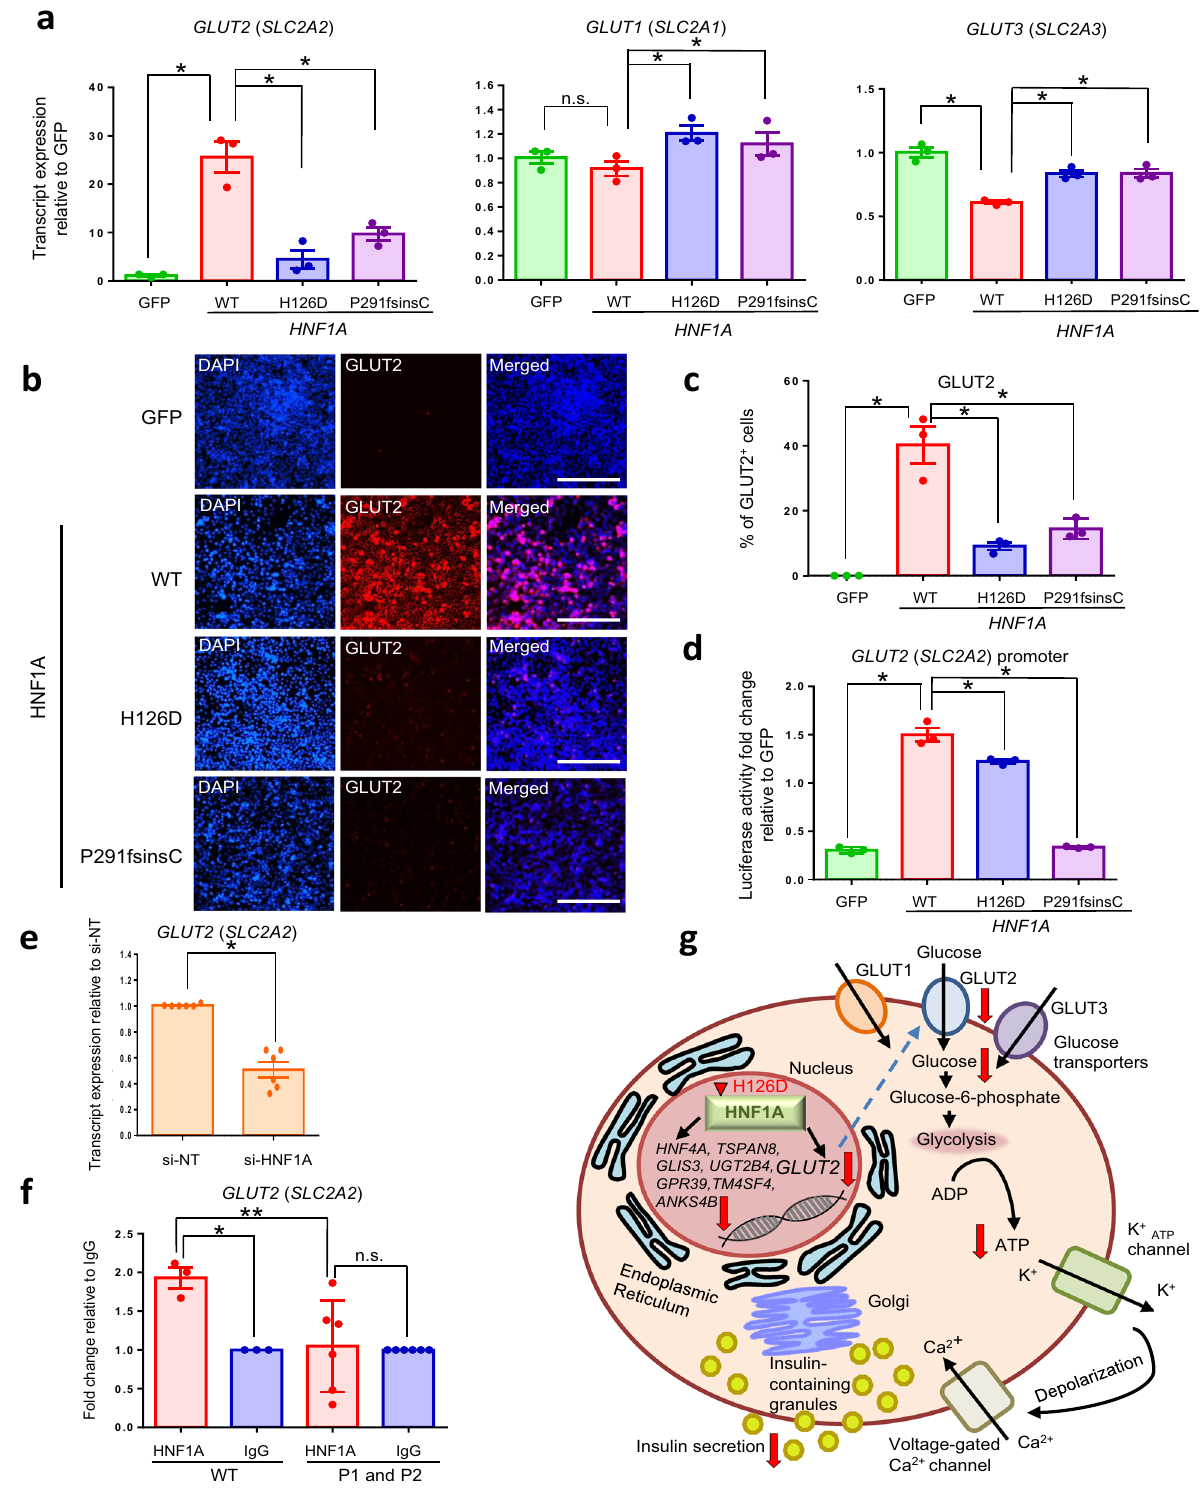
loading concentration with Hybridization buffer (HT1). The NEXTSEQ High Output was performed using the Illumina NEXTSEQ 500 Sequencers with the Illumina ® Reagent v2 (75 cycle kit) Kit. The DNA was attached to the fl owcell surfaces and ampli fi ed to clusters, followed by attachment with the Sequencing primers and run at 1 ×76cycles, generating Single-Read 75 base-pair reads. The images were captured by the NextSeq Control Software (NCS), and the Real Time Analysis (RTA) software converted the images into Basecall (bcl) fi les. All the bcl fi les were then transferred to the server for storage and primary